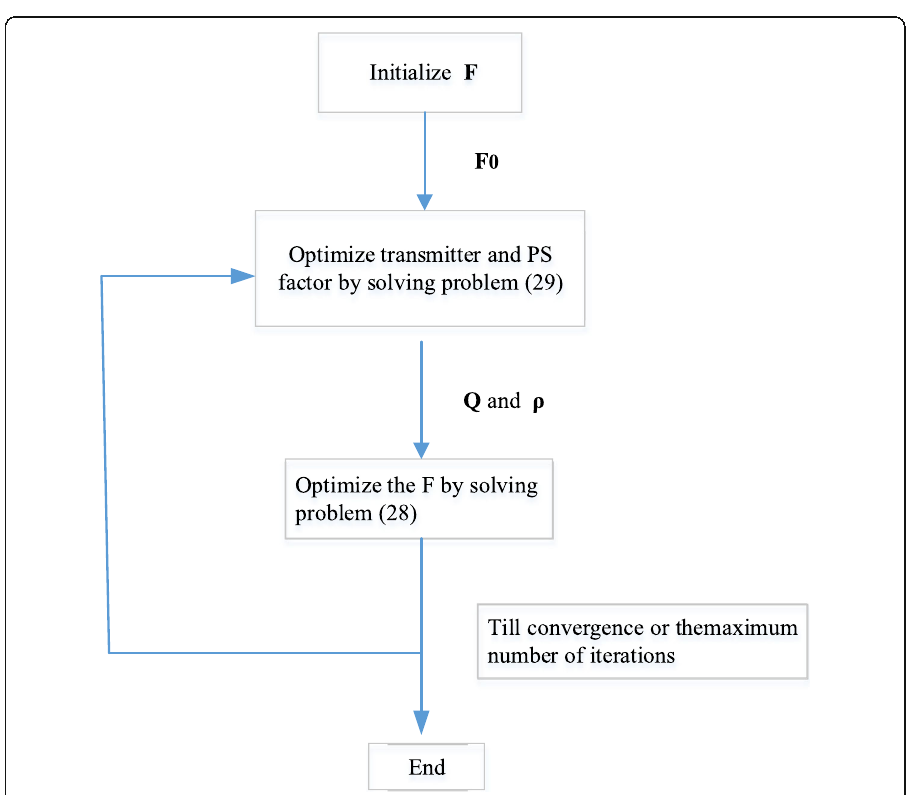
Fig. 2 The process of the iteration algorithm. It shows the process of the iteration algorithm. F represents the receiving filter; Q represents the precoding matrix of transmitter, and ρ represents the power splitting